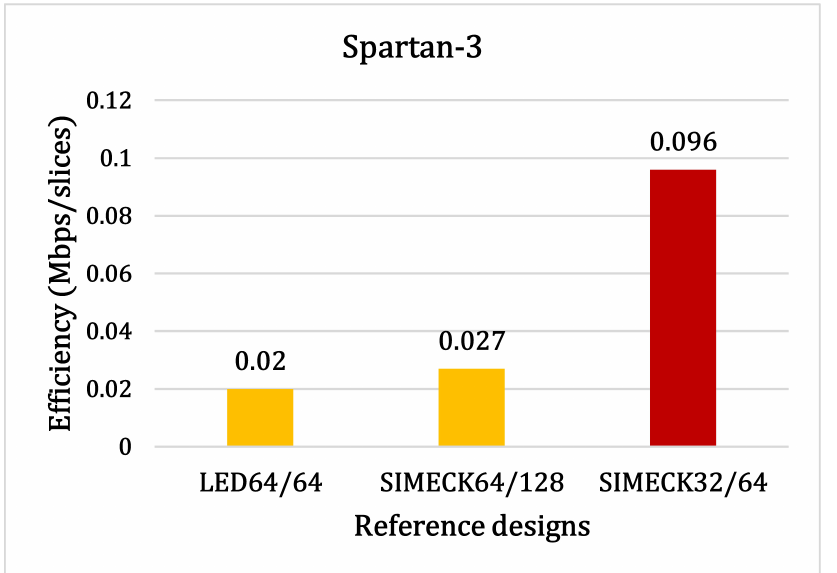
Figure 5. Efficiency evaluation with designs of [28,30] on Spartan-3 FPGA. From left to right, the orange bars with values on top 0.02 and 0.027 are for [28] and [30], respectively. Similarly, a red color bar shows our